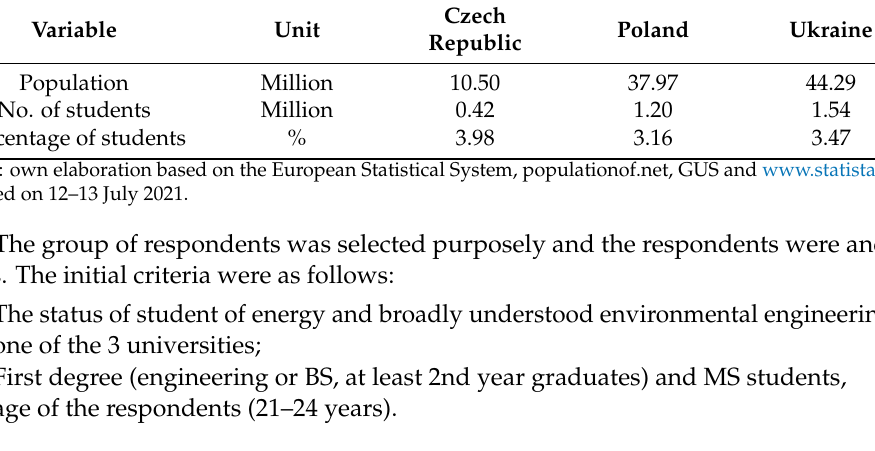
Table 1. Total no. of students and total population in the analyzed countries in 2020.